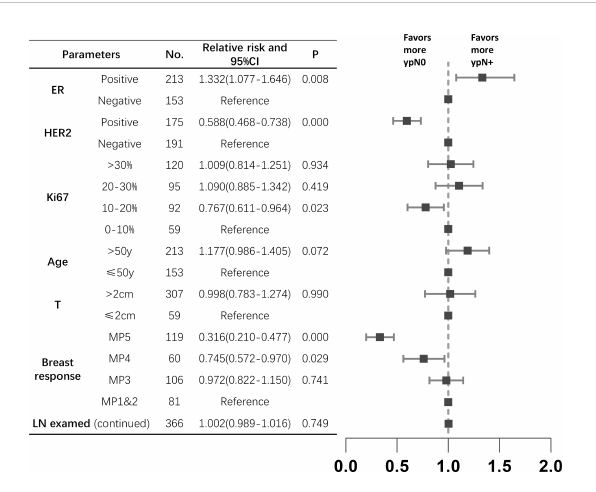
FIGURE 1 The relative risks between clinicopathological characteristics and axillary response in pre-N+ patients (n=366). ER, estrogen receptor; HER2, human epidermal growth factor receptor2; MP, Miller-Payne; LN, lymph node; CI, con fi dence